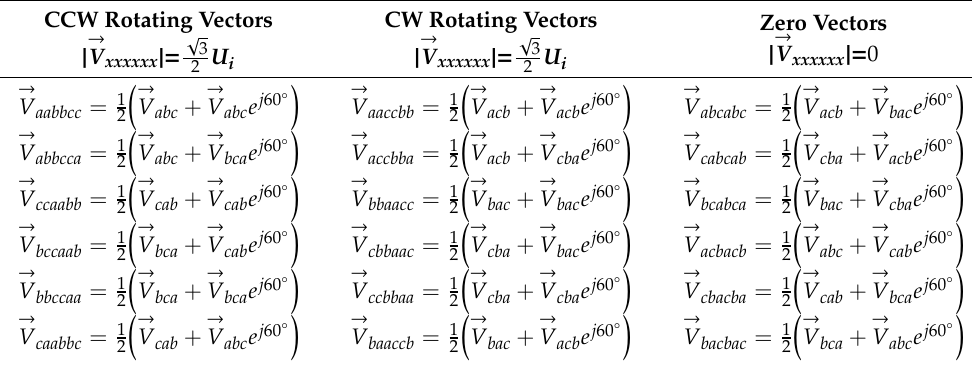
Figure 5. Switch duty cycles during T s switching period in three-to-six-phase MC for output phase numbers 1, 3 and 5; numbers 2, 4, and 6. Table 2. The names and relationships defining the rotating and zero voltage space vectors resulting in elimination of the CMV in three-to-six-phase MC.